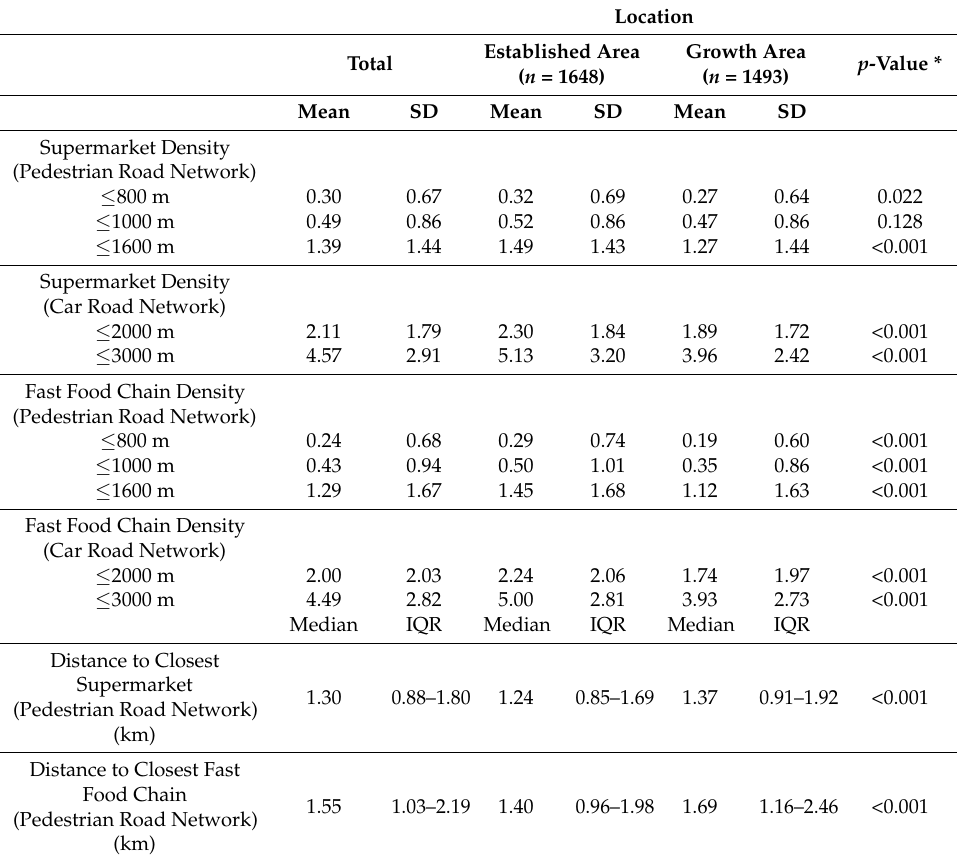
Table 2. Geographic measures of supermarket and fast food chain access by location: established versus urban-growth local government area.